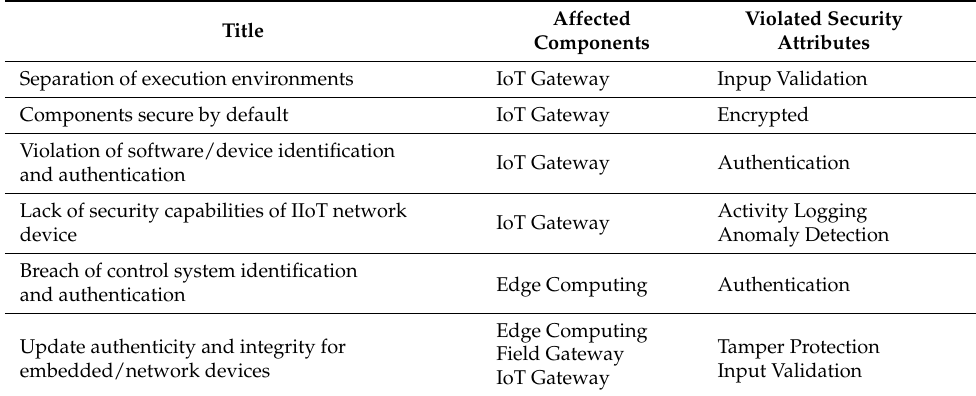
Table A1. Potential threats identified by